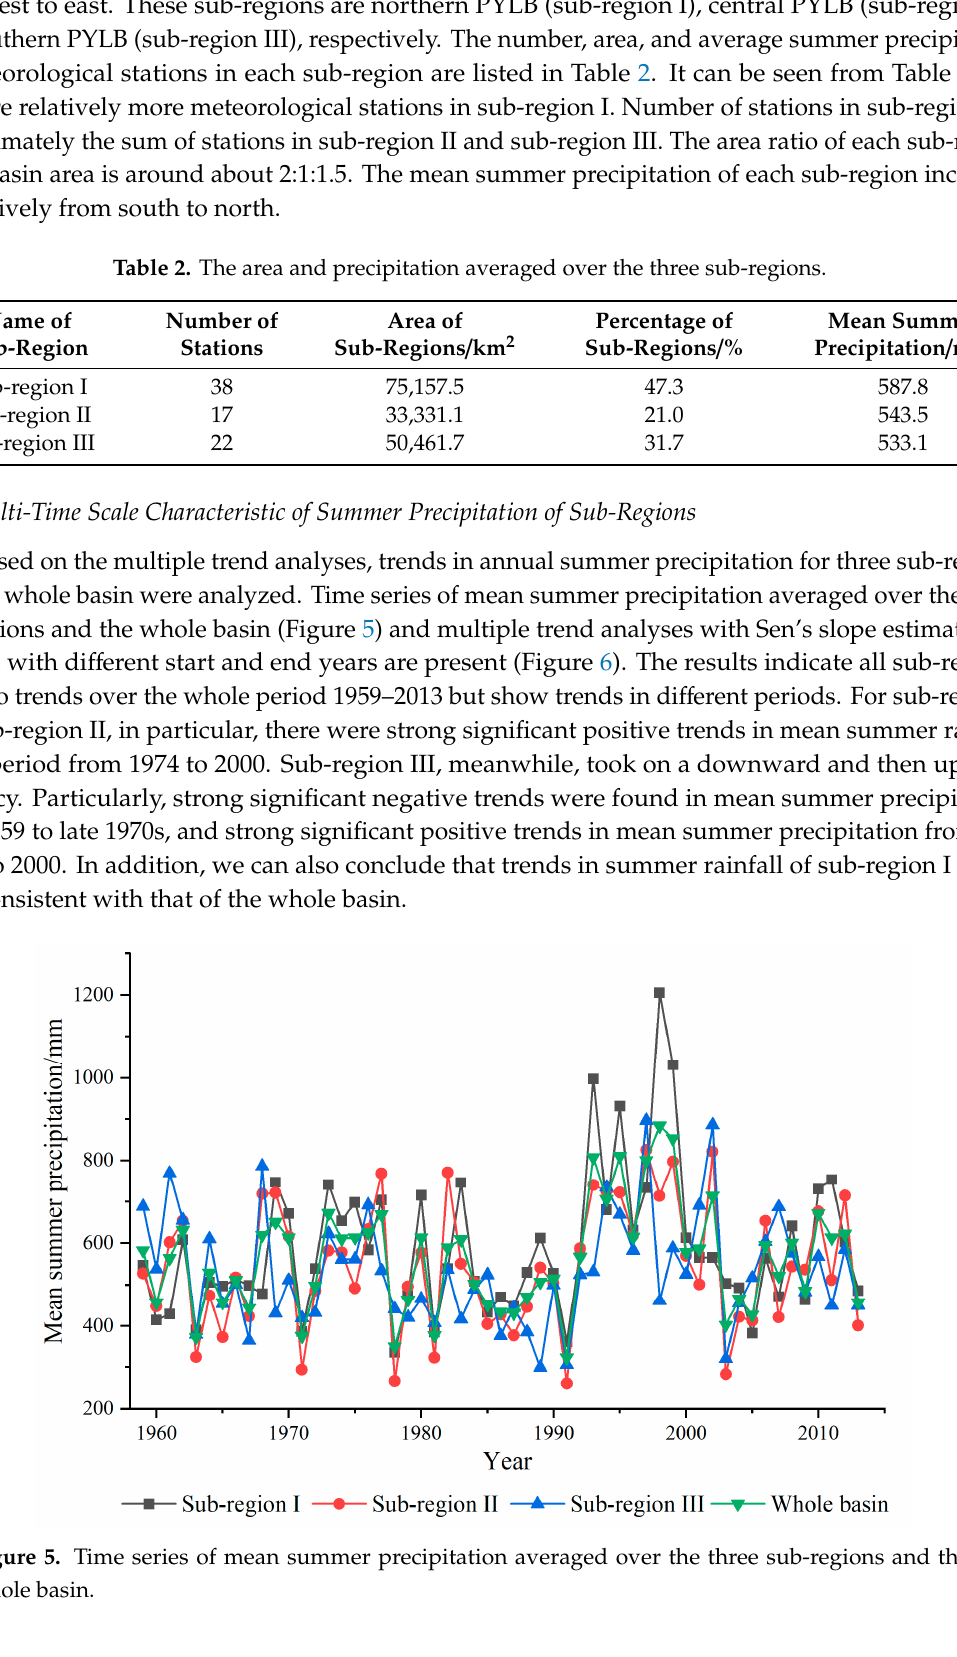
Figure 6. Multiple trend analyses for mean summer precipitation of sub-regions and the whole basin. The colour scale indicates the change in mean summer rainfall in mm per decade. The thick blue and black contours delineate areas of significant trends at 1 and 5% significance level, respectively. The wavelet power spectrum structures of summer precipitation time series in different sub-regions and the whole basin are seen in Figure 7. It can be seen from Figure 7 that the mean